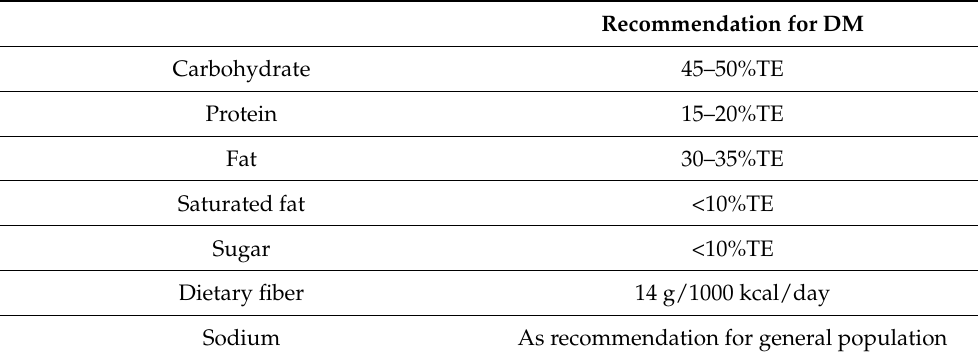
Table 1. Nutritional recommendations for children and adolescents with type 1 diabetes mellitus from the International Society of Pediatric and Adolescent Diabetes (ISPAD).